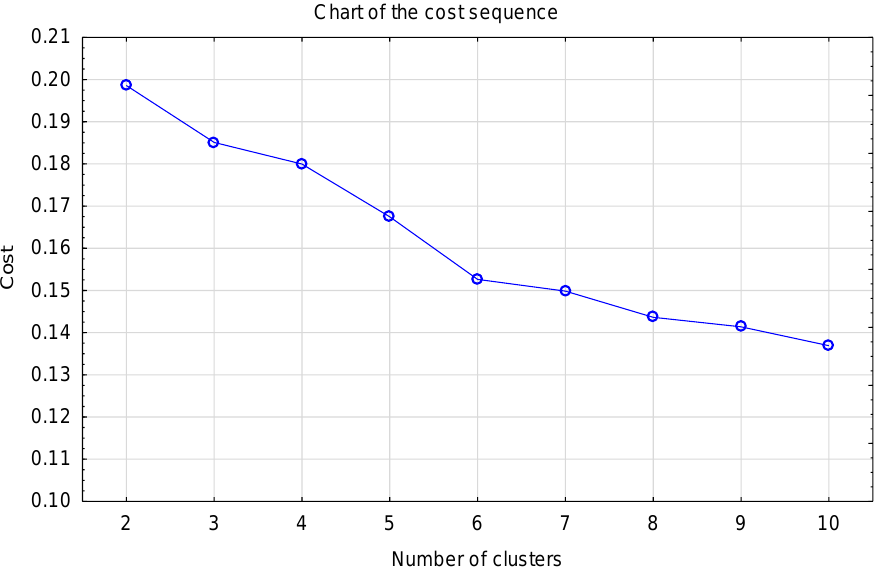
Figure 4. Cost sequence in relation for the number of clusters for v-fold cross-validation for database III and k-mean algorithm with Euclidean distance.